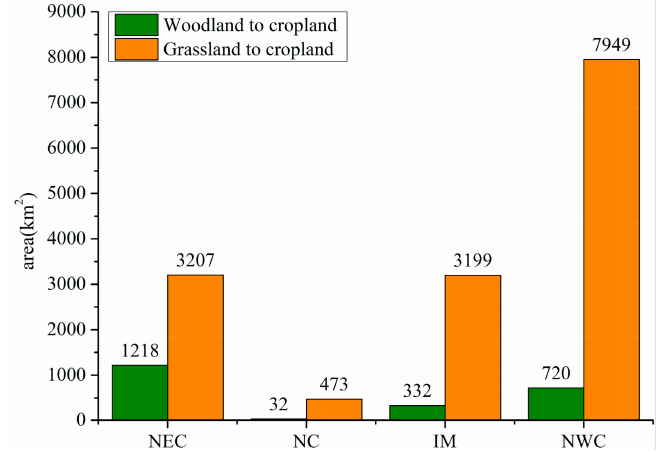
Figure 3. Area of cropland expansion in different climate zones of northern